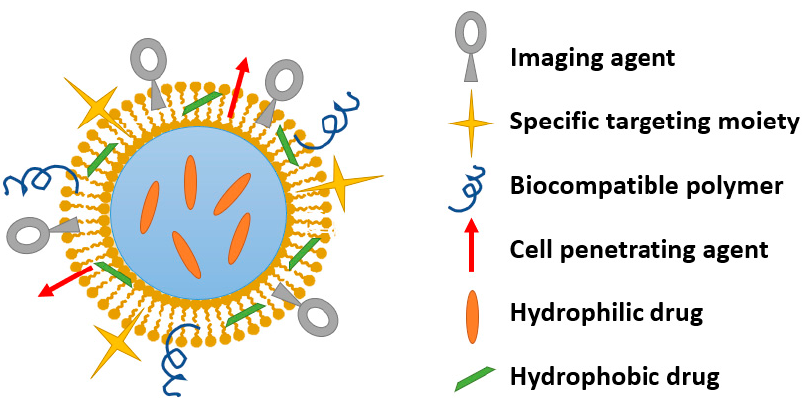
Figure 5. Schematic representation of a multifunctional nanoparticle. Created based on information from literature references [125–128].